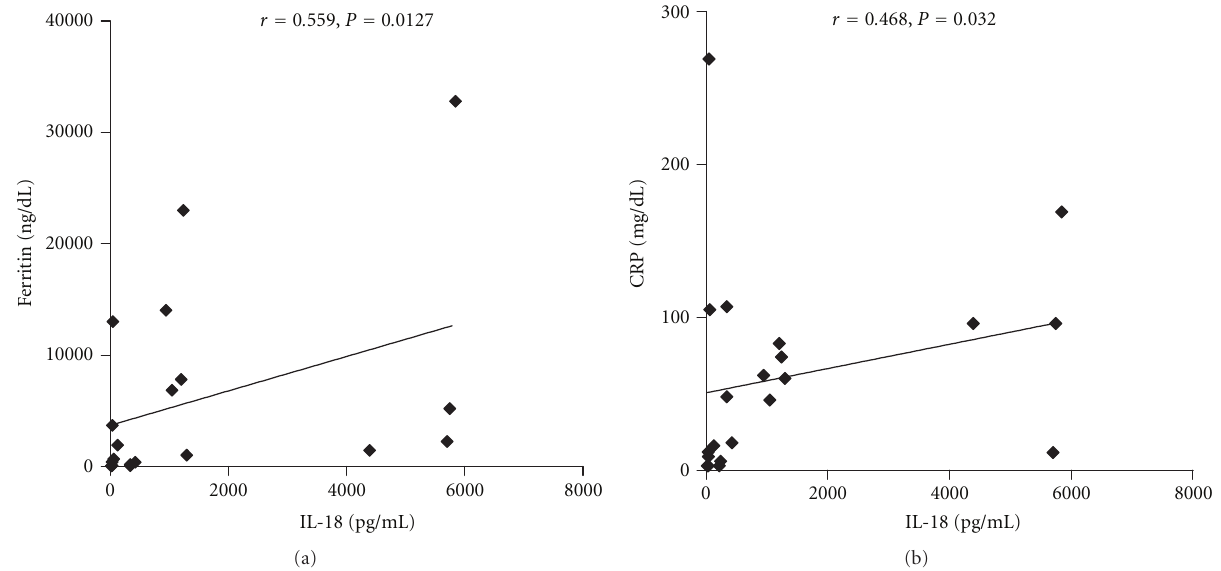
Figure 5: (a) Correlation between CRP serum levels and IL-18 serum levels. (b) Correlation between serum ferritin levels and IL-18 serum